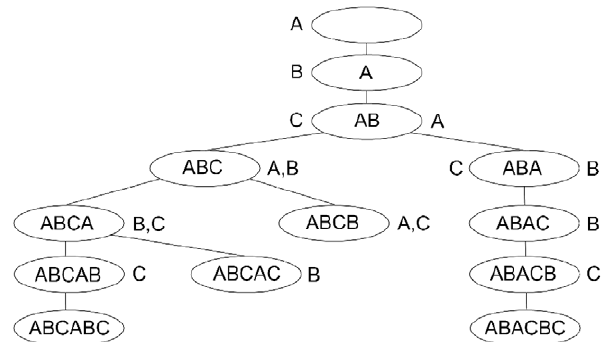
Figure 3. Primitive pseudoknot tree constructed with 3 arcs. Characters on the left of any internal node belong to the FIFO left end character queue, while those on its right belong to the right end character set. Nodes with pseudoknot pattern token ABCB cannot be extended because appending the right end character A violates rule 3, while appending character C violates rule 2. Similarly, for nodes with token ABCAC, appending character B also violates rule 3. At the lowest leaf node level, we obtain tokens ABCABC (pseudotrefoil) and ABACBC (kissing hairpin).